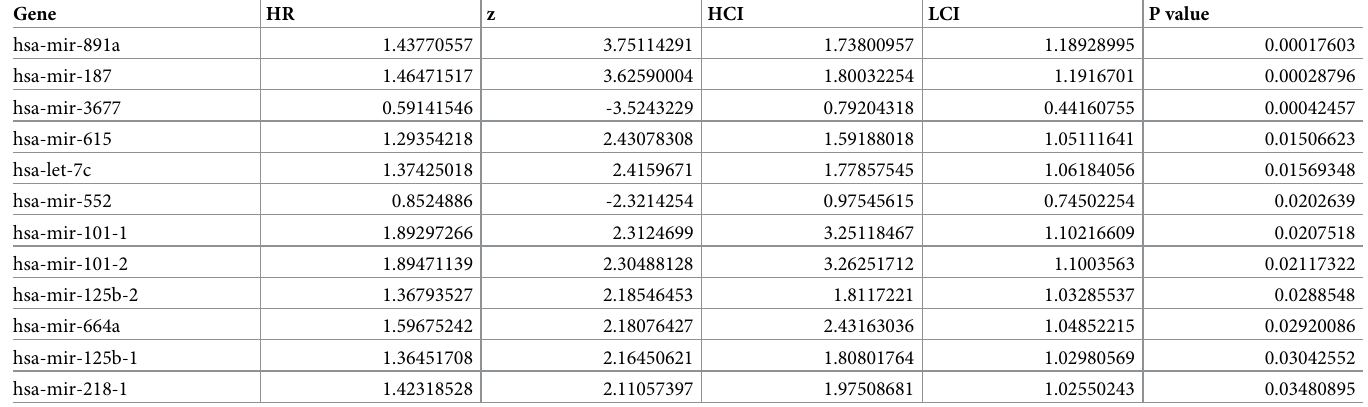
Table 2. Thirteen miRNAs were filtered by the single-factor CoxPH regression model.